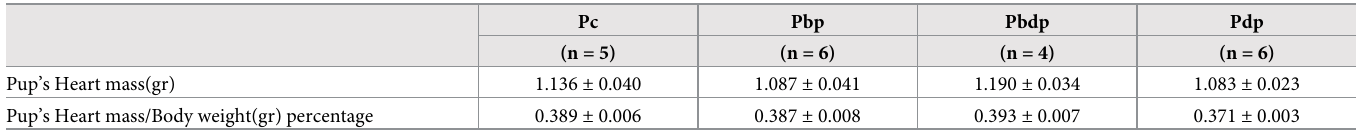
Table 5. Pups weight characteristics.